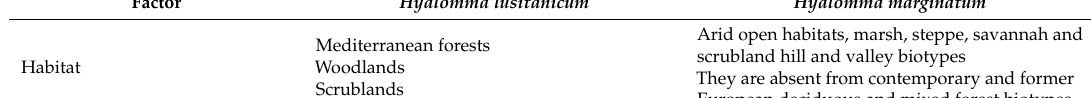
Arid open habitats, marsh, steppe, savannah and scrubland hill and valley biotypes They are absent from contemporary and former European deciduous and mixed forest